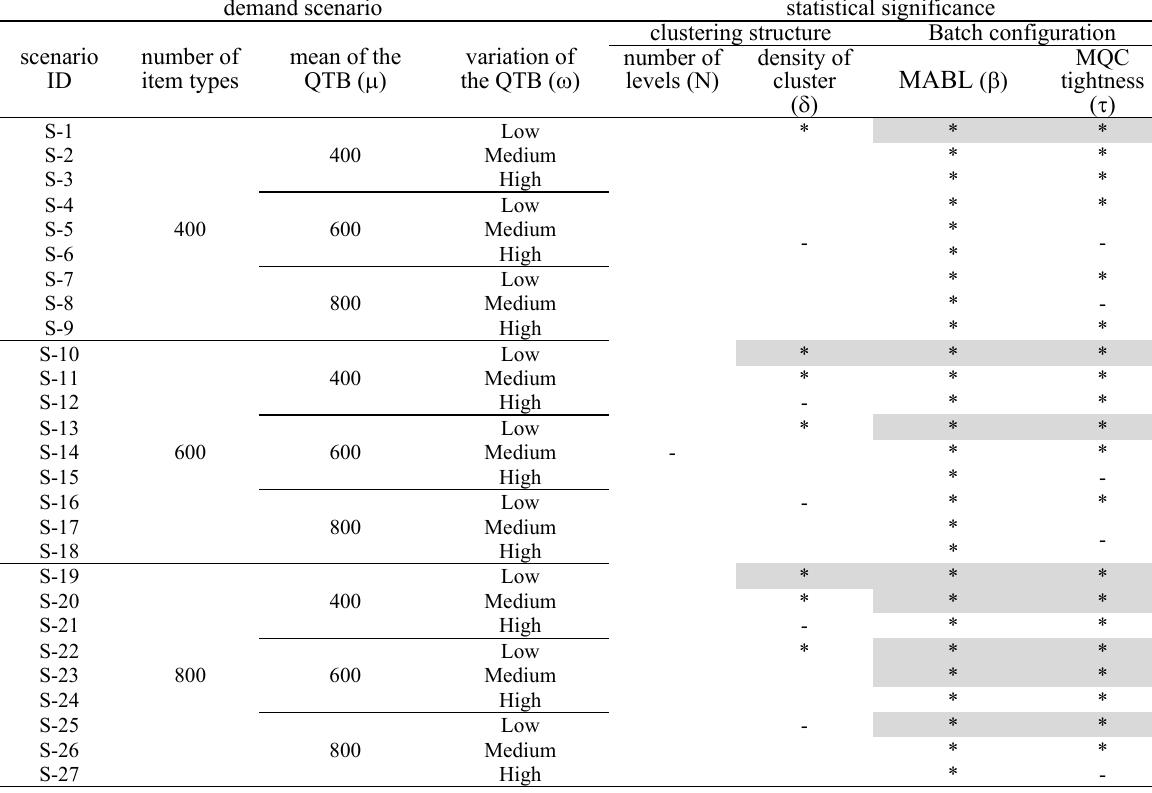
Results of ANOVA for N-level sequential batching demand scenario statistical